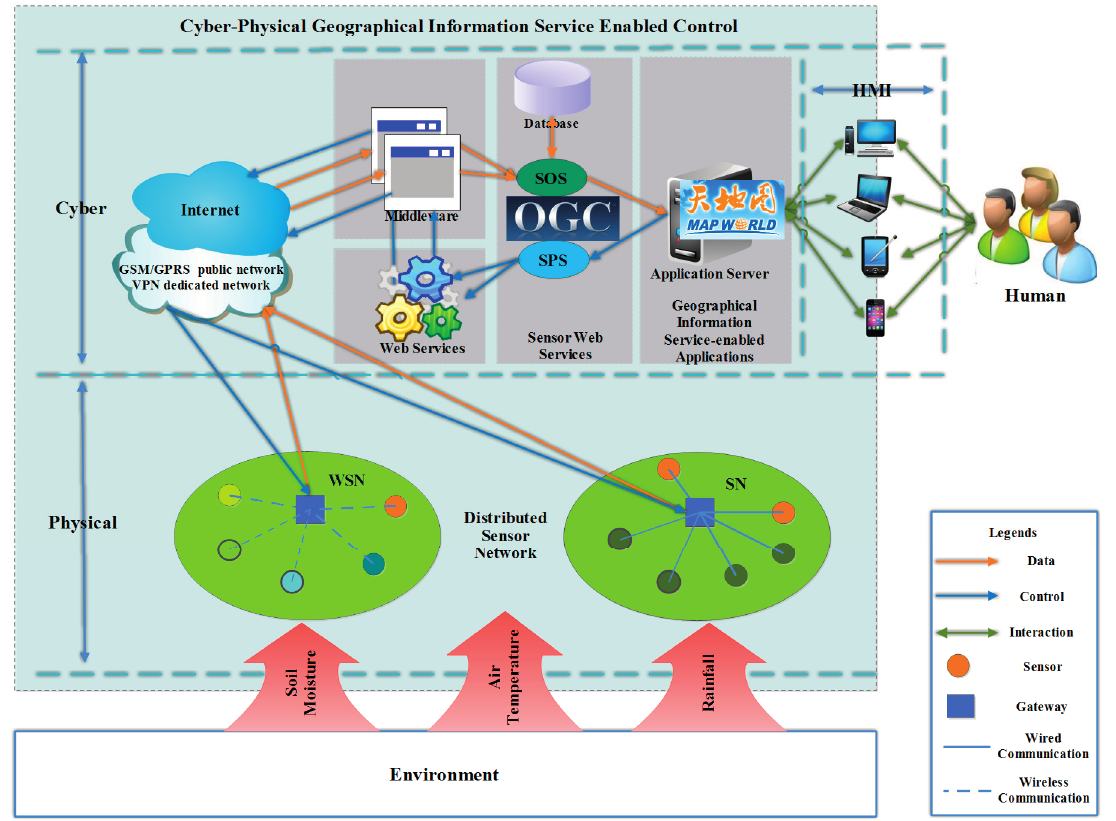
Figure 1. Architecture of cyber-physical geographical information service-enabled control of diverse in-situ